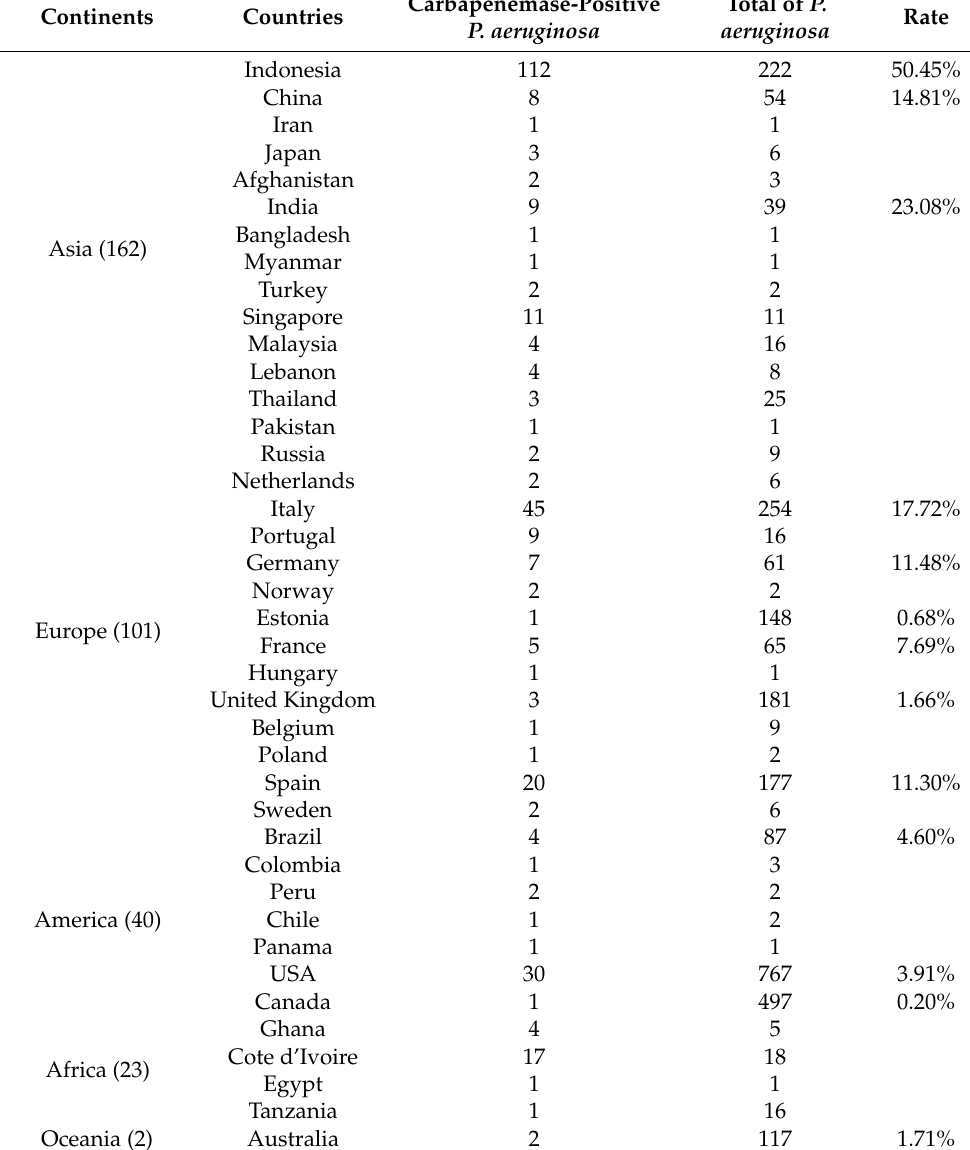
Table A1. Distribution of carbapenemase-positive P. aeruginosa in various countries.